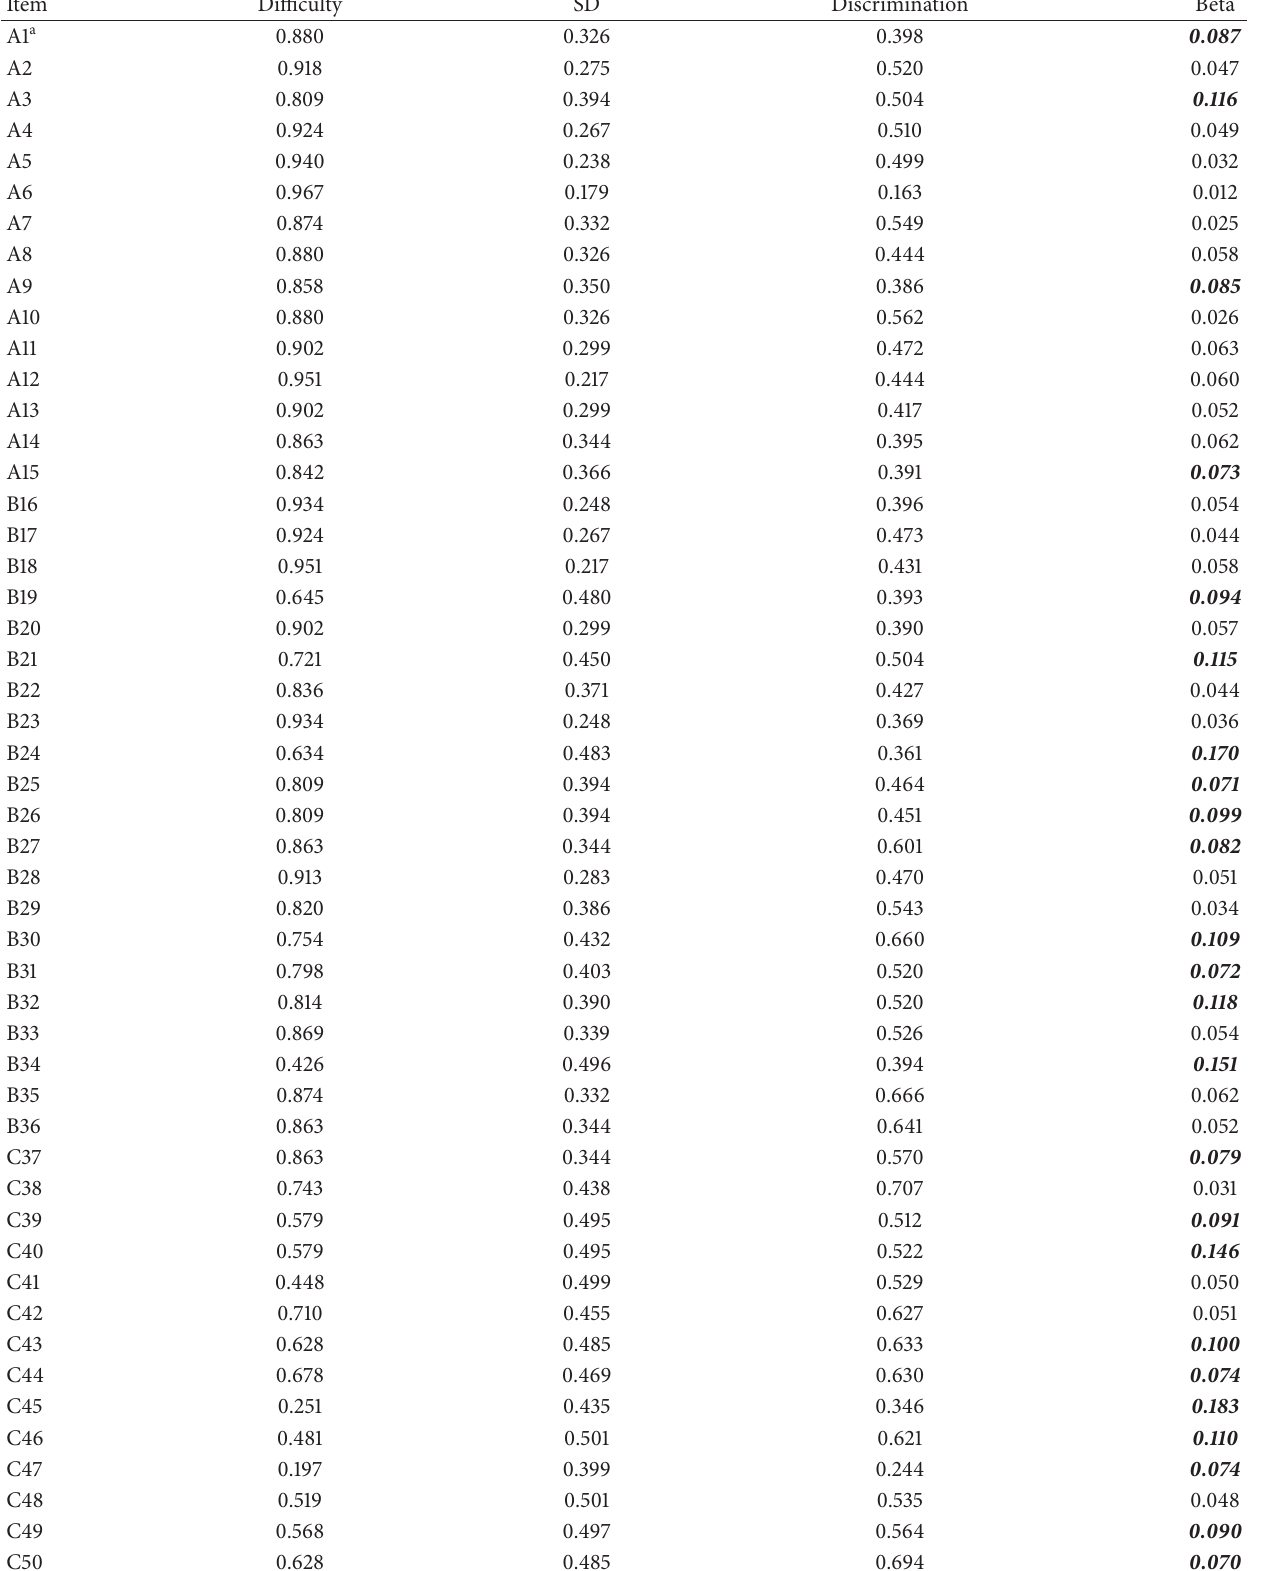
Table 2: Item difficulties, discriminations, and